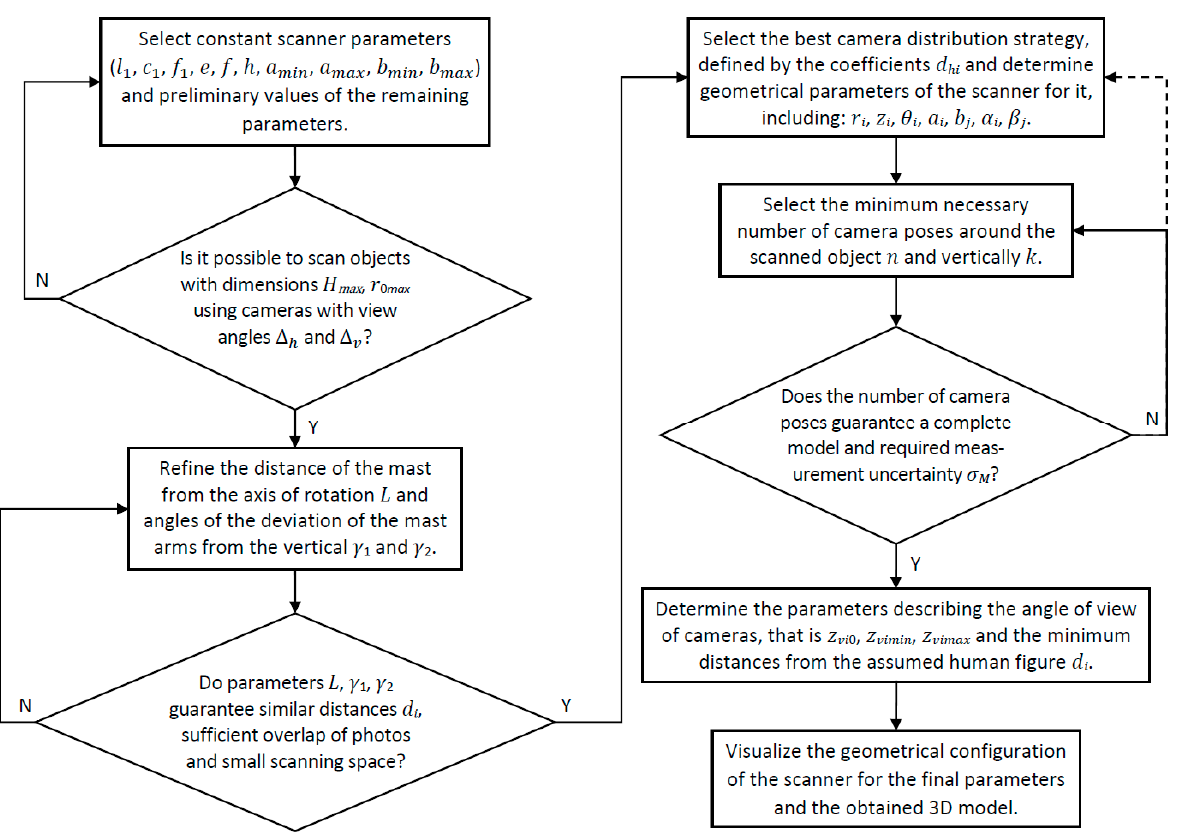
Figure 5. The method of selecting the geometrical parameters of the scanner.